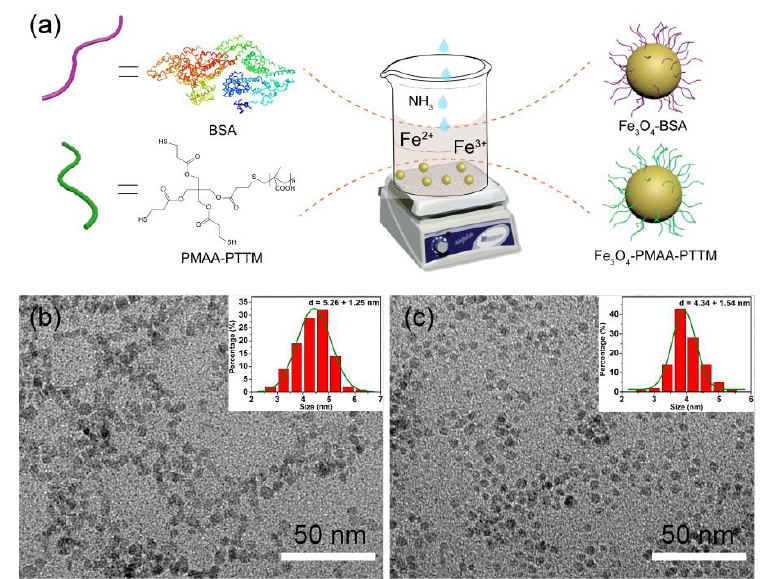
Figure 1. ( a ) Schematic illustration of the fabrication process of Fe 3 O 4 -BSA and Fe 3 O 4 -PMAA-PTTM nanoparticles; Transmission electron microscopy (TEM) images of ( b ) Fe 3 O 4 -BSA and ( c ) Fe 3 O 4 -PMAA-PTTM nanoparticles.